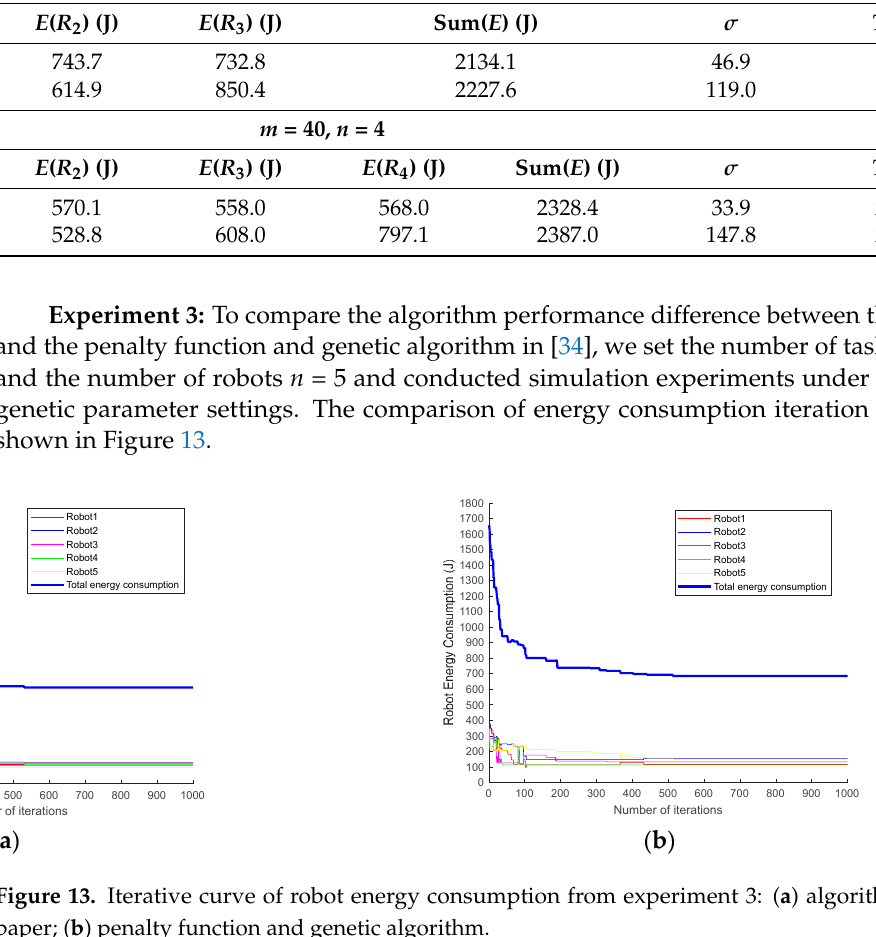
Table 2. Comparison of algorithm parameters from Experiment 2.